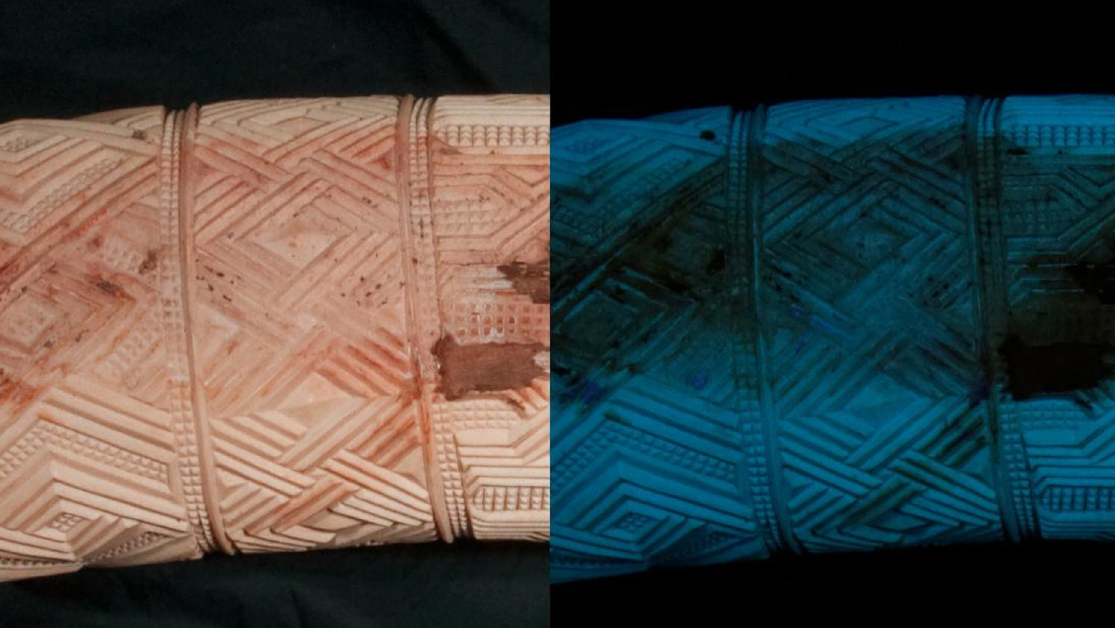
Fig. 4.6. Decorated ivory tusk suffering from humidity. Although visible under white light, the damaged parts are clearly enhanced by UV fluorescence (on the